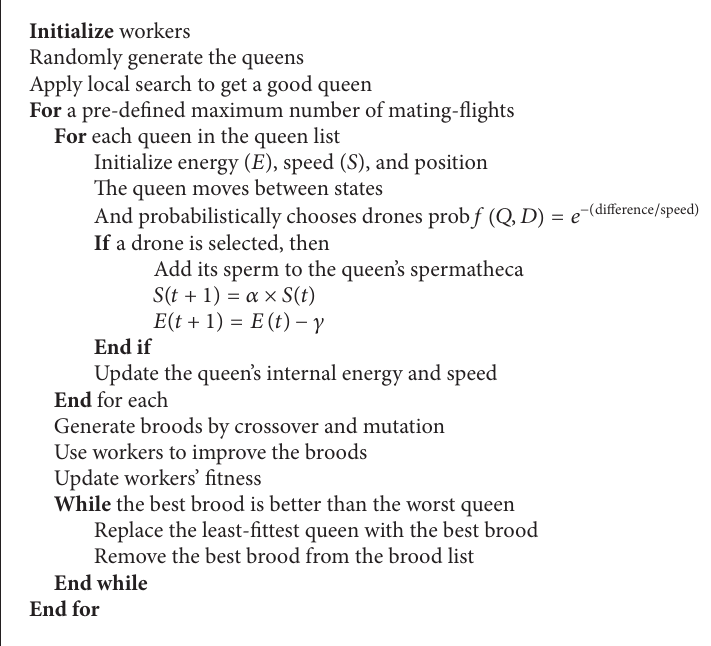
Algorithm 1: Original MBO algorithm